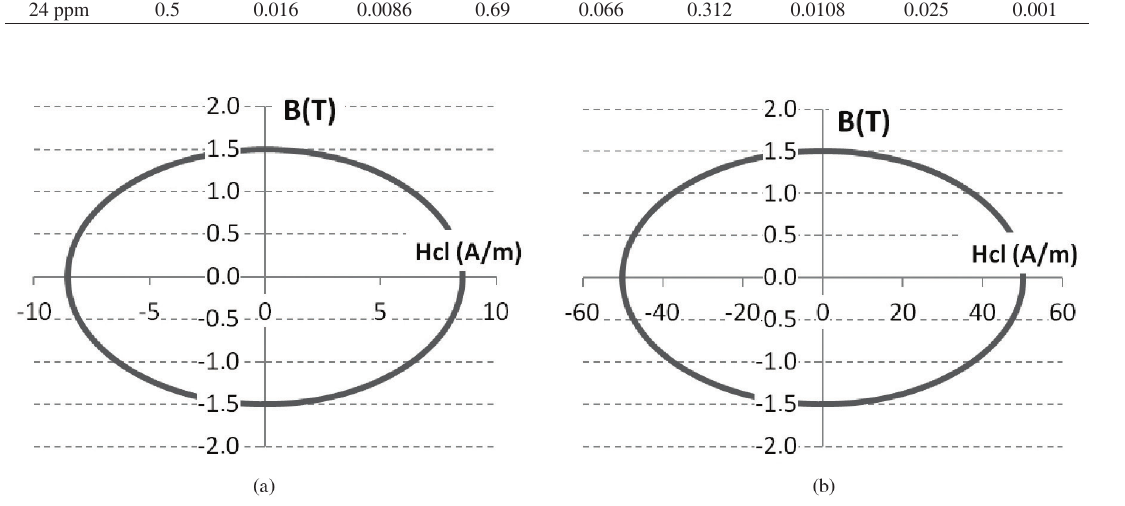
Figure 1. B x H loops for GO (A) and NO (B) samples for a magnetization cycle with maximum induction 1.5 T and frequency 60 Hz. cl